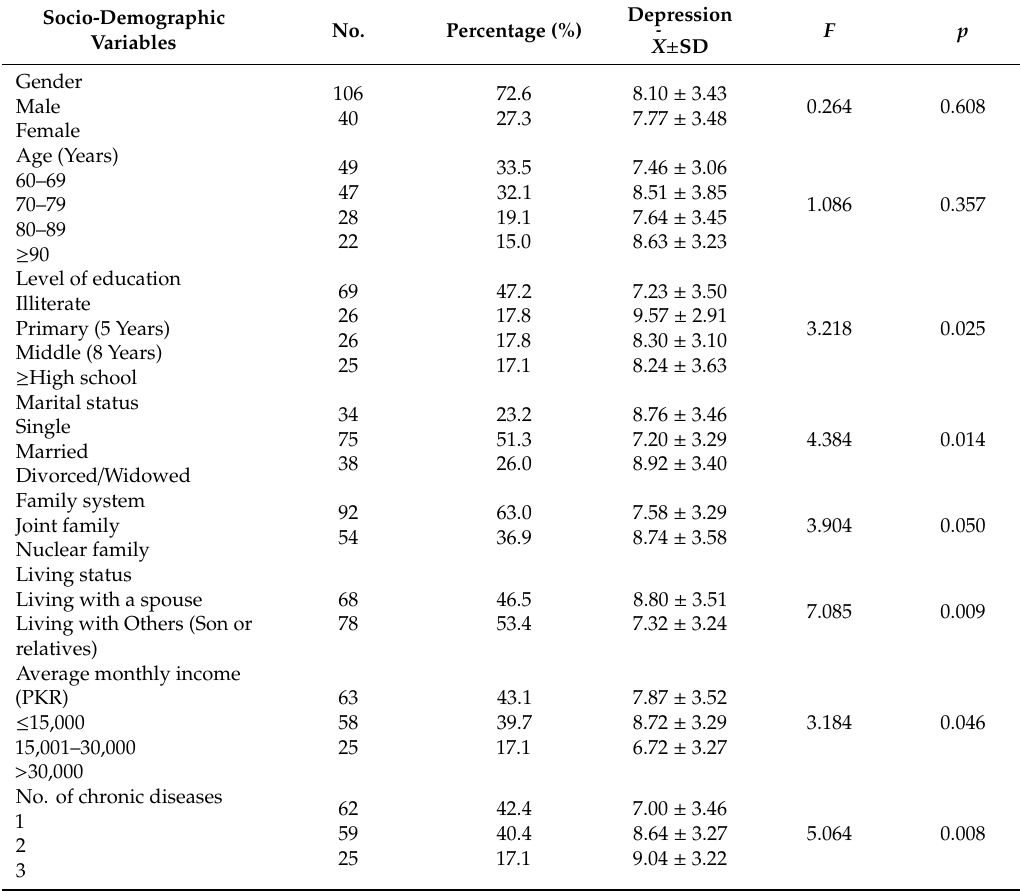
Table 1. Comparison of di ff erent socio-demographic characteristics with depressive